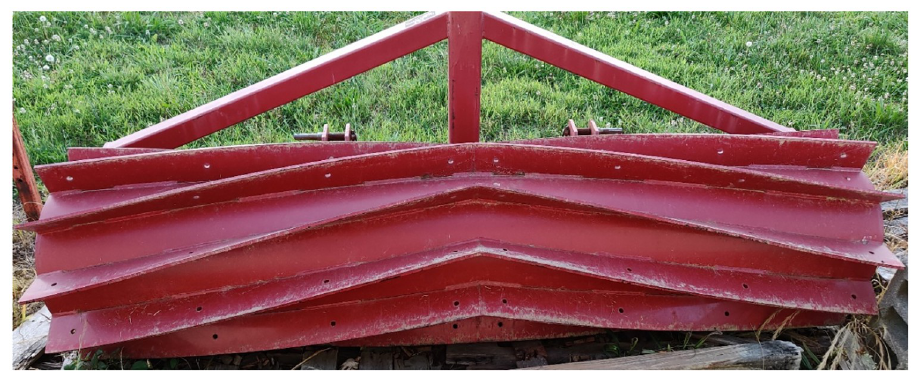
Fig 1. V-bar roller crimper (I&J Manufacturing, Gordonville, PA); 2.4 m in length, 38 cm diameter, 9.5 mm thickness, weighing 1002 kg used for rolling-crimping treatment.